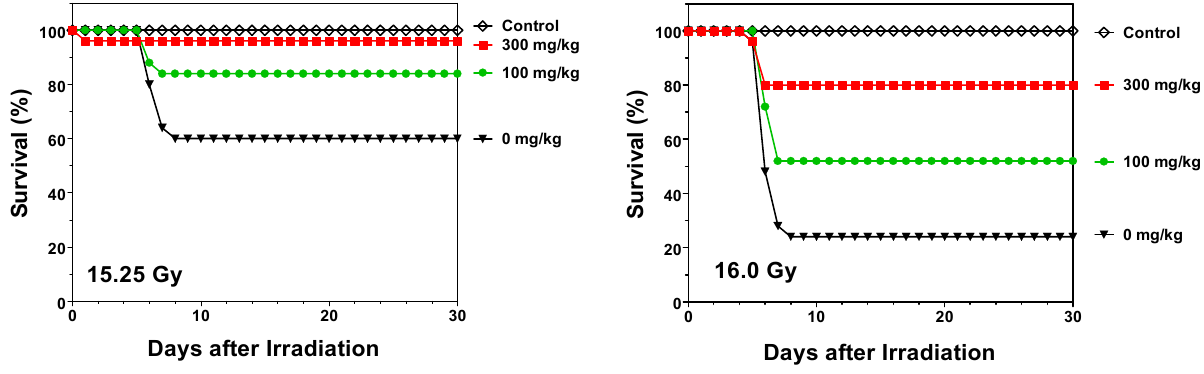
Figure 4. Single-dose opaganib improves survival of partially shielded irradiated mice. C57BL/6 mice were orally treated with 0 ( ▼ ), 100 ( ● ) or 300 ( ∎ ) mg/kg opaganib 4 h before being exposed to 15.25 ( Left Panel ) or 16.0 ( Right Panel ) Gy irradiation with 5% bone marrow shielding. Control mice did not receive opaganib or radiation ( ◊ ). Mice were monitored for survival for 30 days.